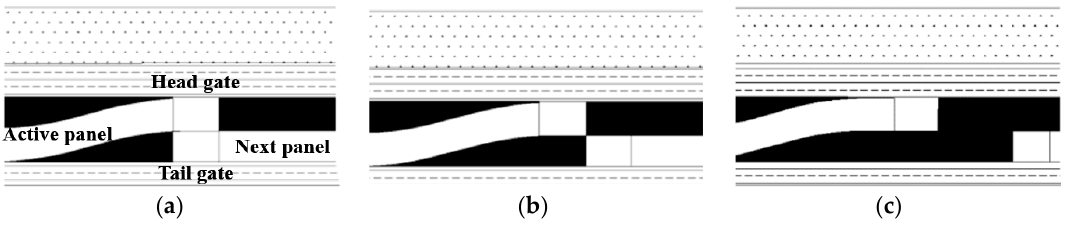
Figure 1. Split-level panel forms (cross-section view). ( a ) Negative coal pillar; ( b ) Zero coal pillar; ( c ) Positive coal pillar.